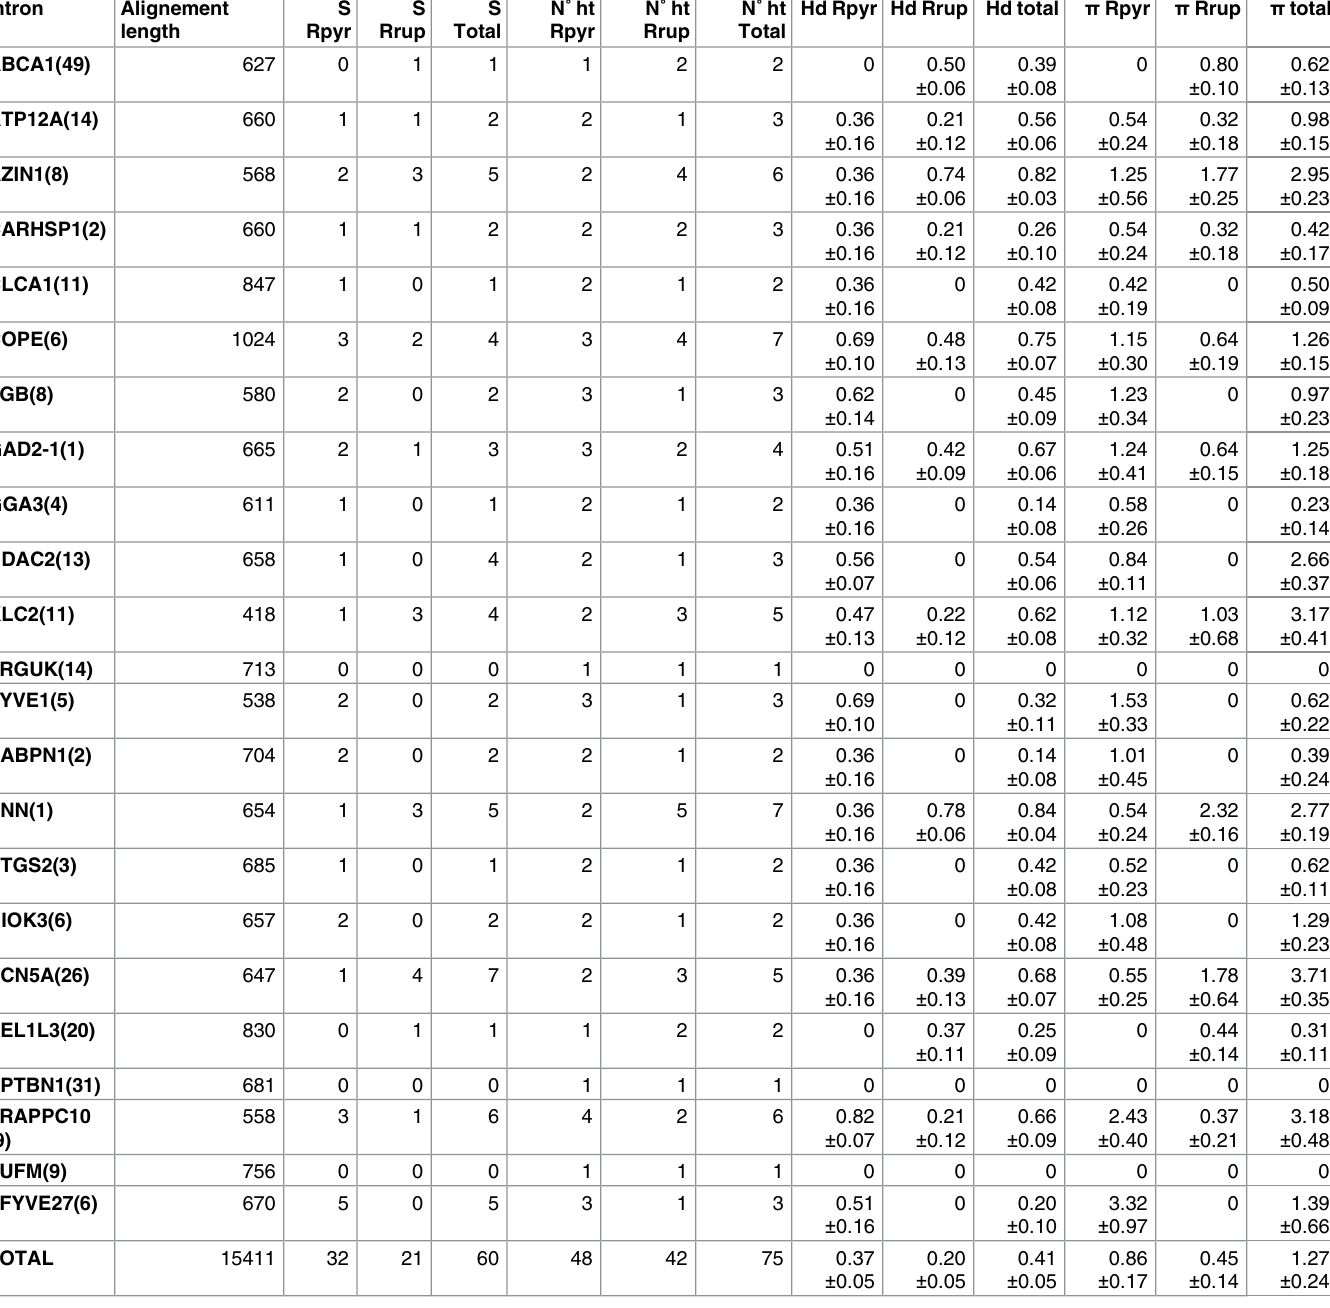
Table 1. Genetic diversity in chamois. Estimates are providedfor each putative especies, R . pyrenaica (Rpyr) and R . rupicapra (Rrup), separately and for the total.